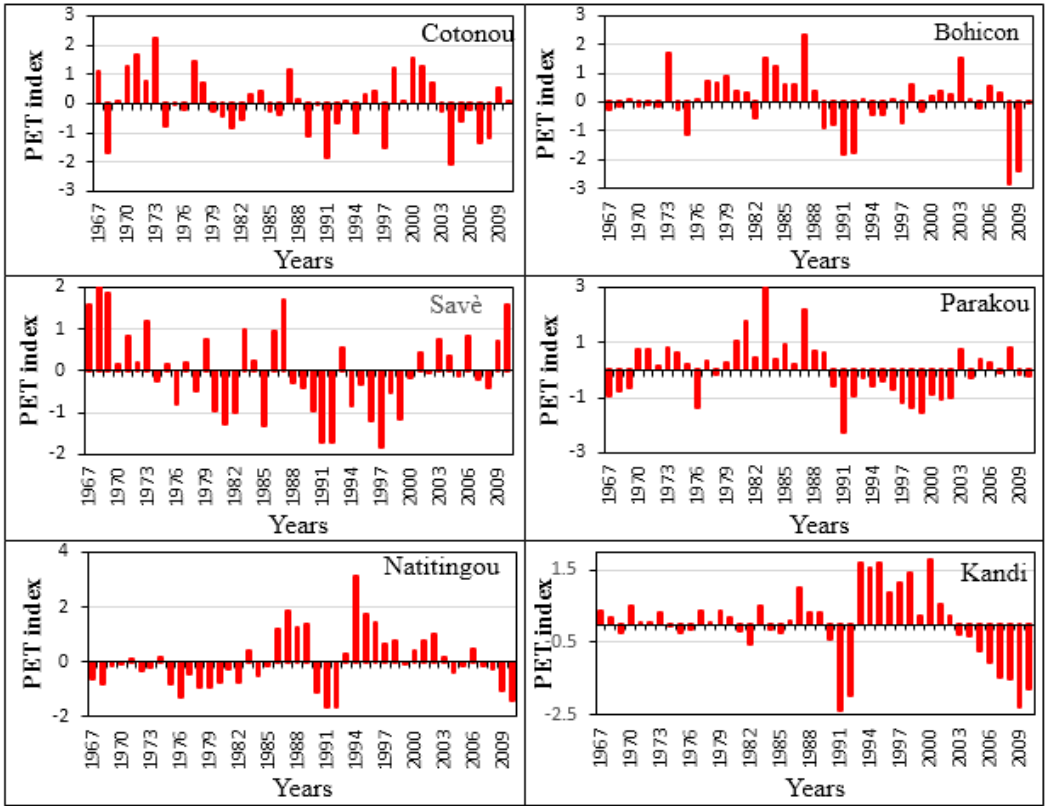
Figure 2. Evolution of Annual PET index over the reference period.